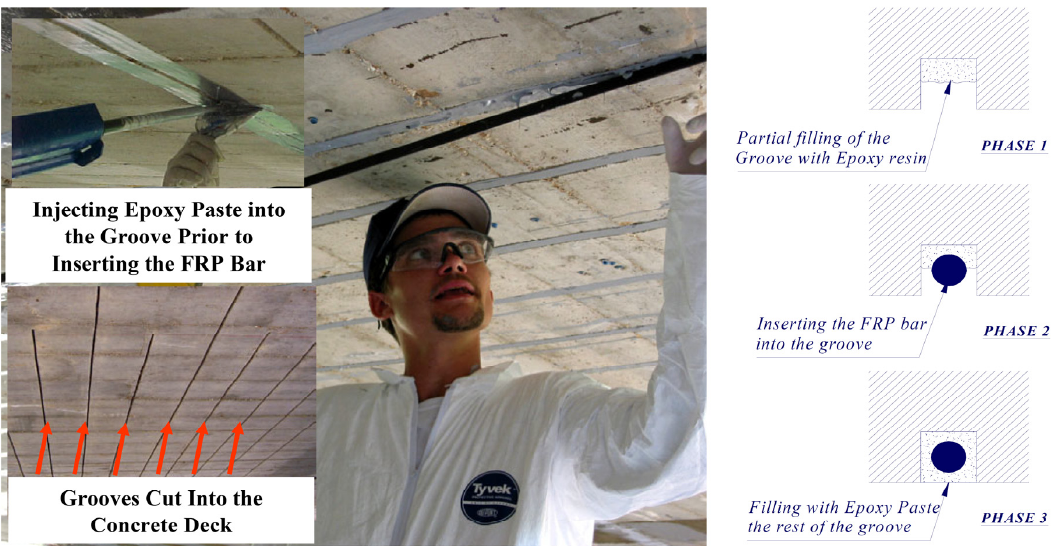
Figure 7. Implementation procedure for the prestressed NSM technique [72].